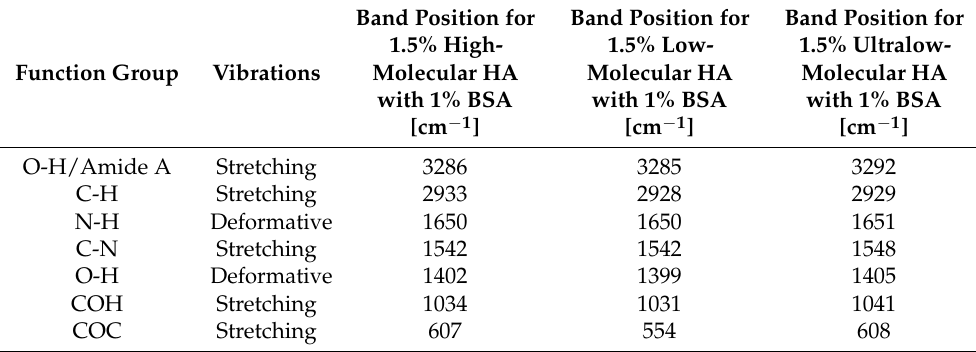
Table 3. The positions of bands in IR spectra (wavenumbers) for the mixtures of high-, low-, and ultralow-molecular-weight HA with bovine serum albumin.